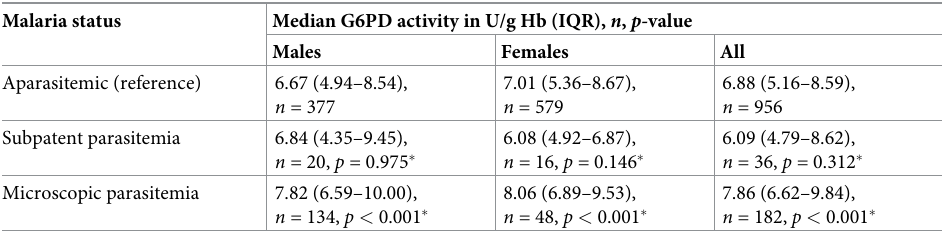
Table 2. Distribution of median G6PD activity stratified by sex and malaria status.